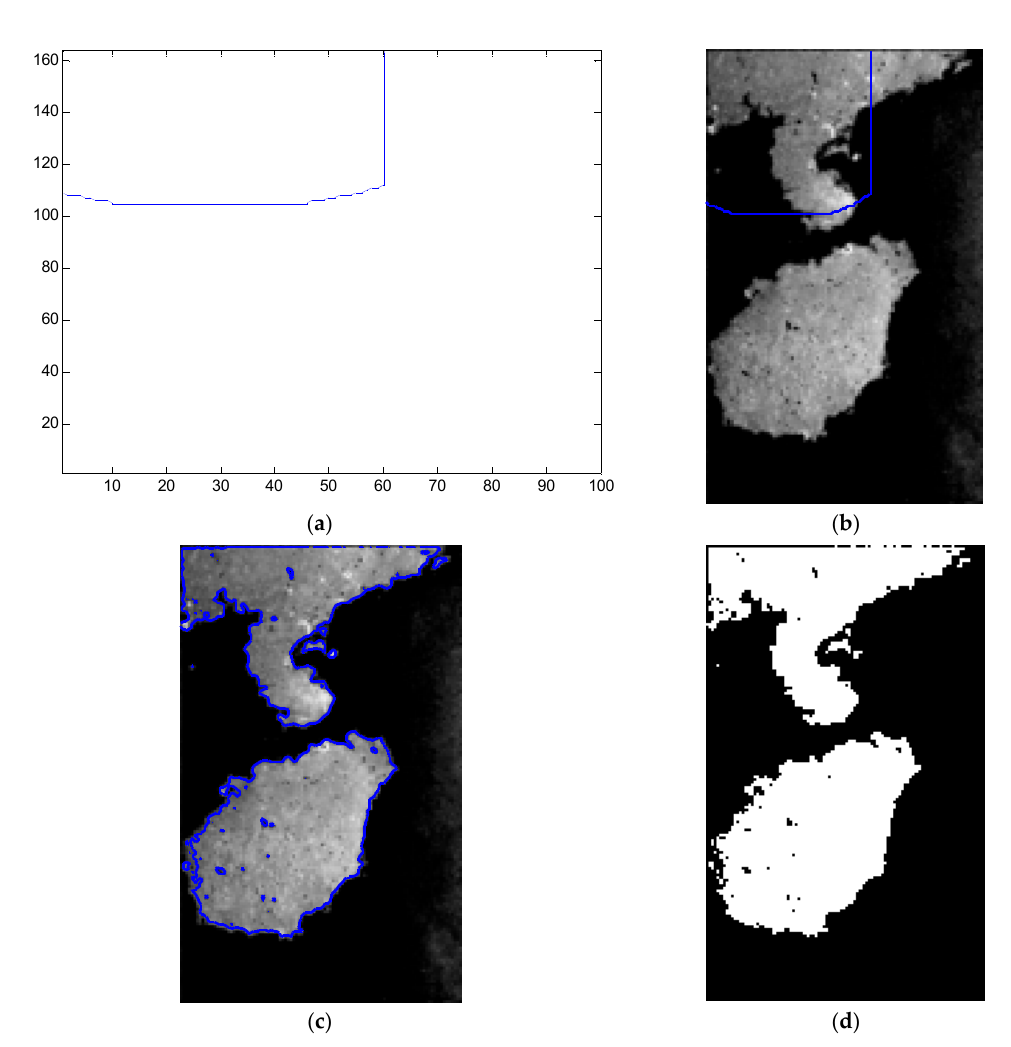
Figure 9. Large initial contour extraction results: ( a ) Large initial contour of target image; ( b ) The position of large initial contour in target image; ( c ) Shoreline extraction result; ( d ) Binary map of the extraction results of shoreline.